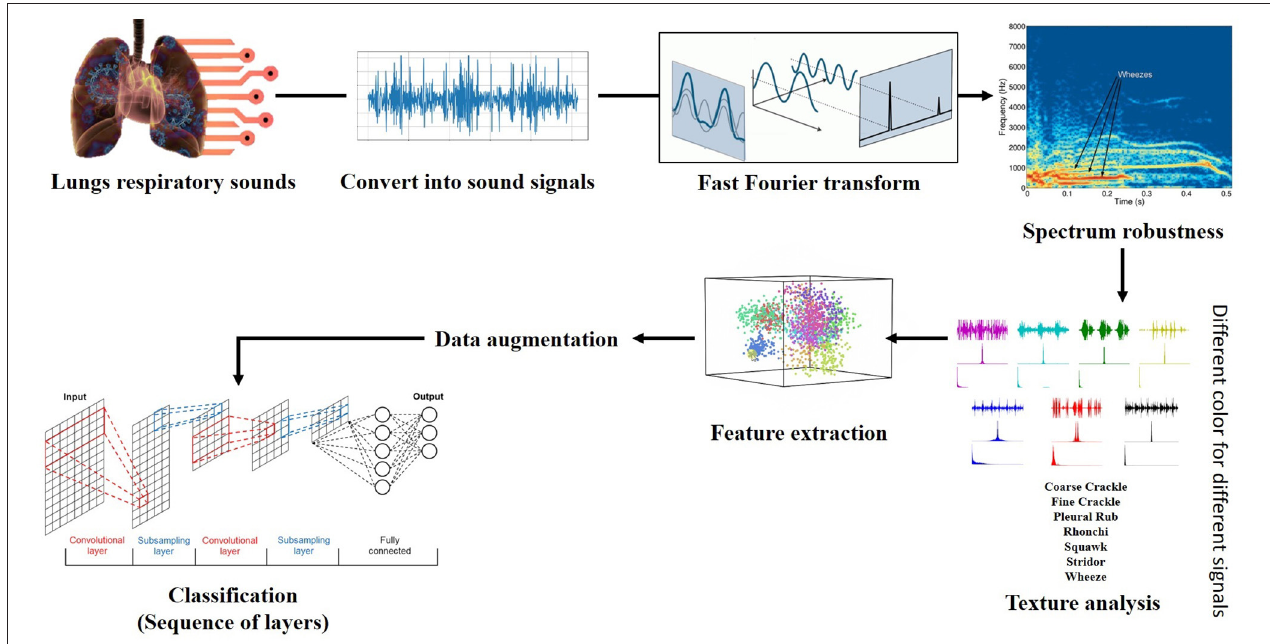
FIGURE 3 | Architecture of proposed